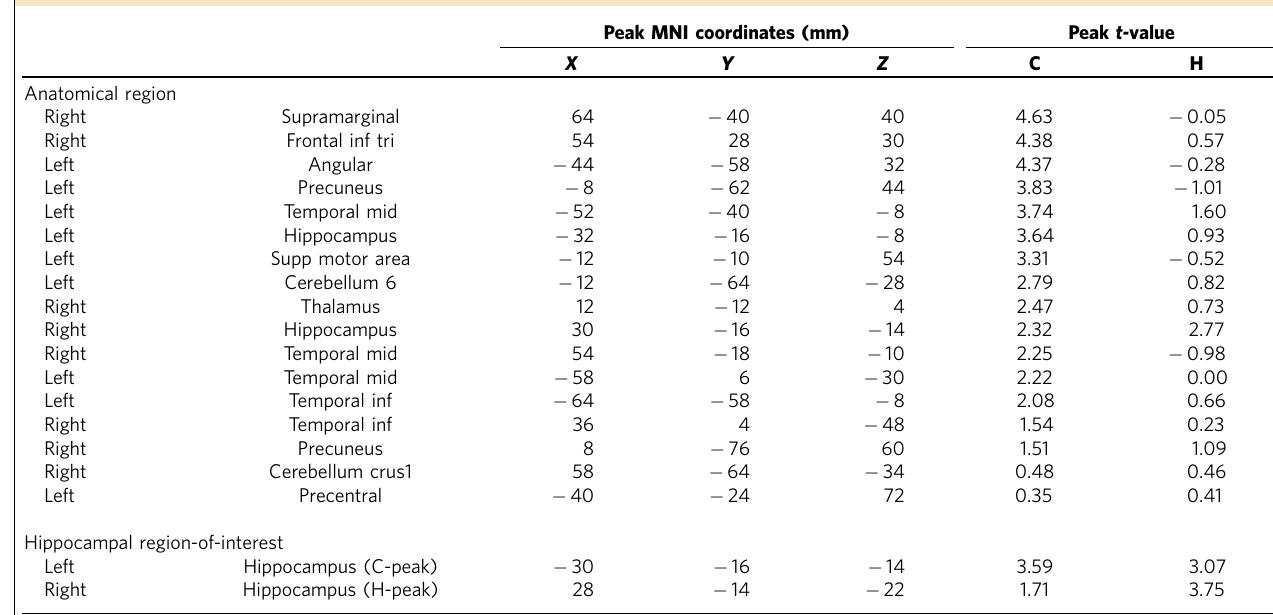
Table 1 | List of brain regions representing conjunctive information and their hubness